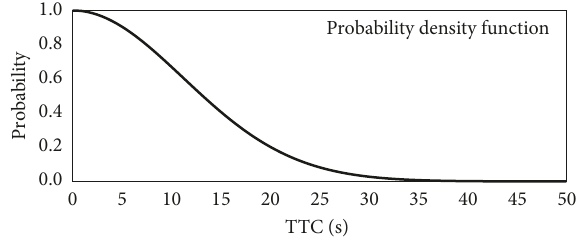
Figure 4: PDF for a near-crash event becomes a real